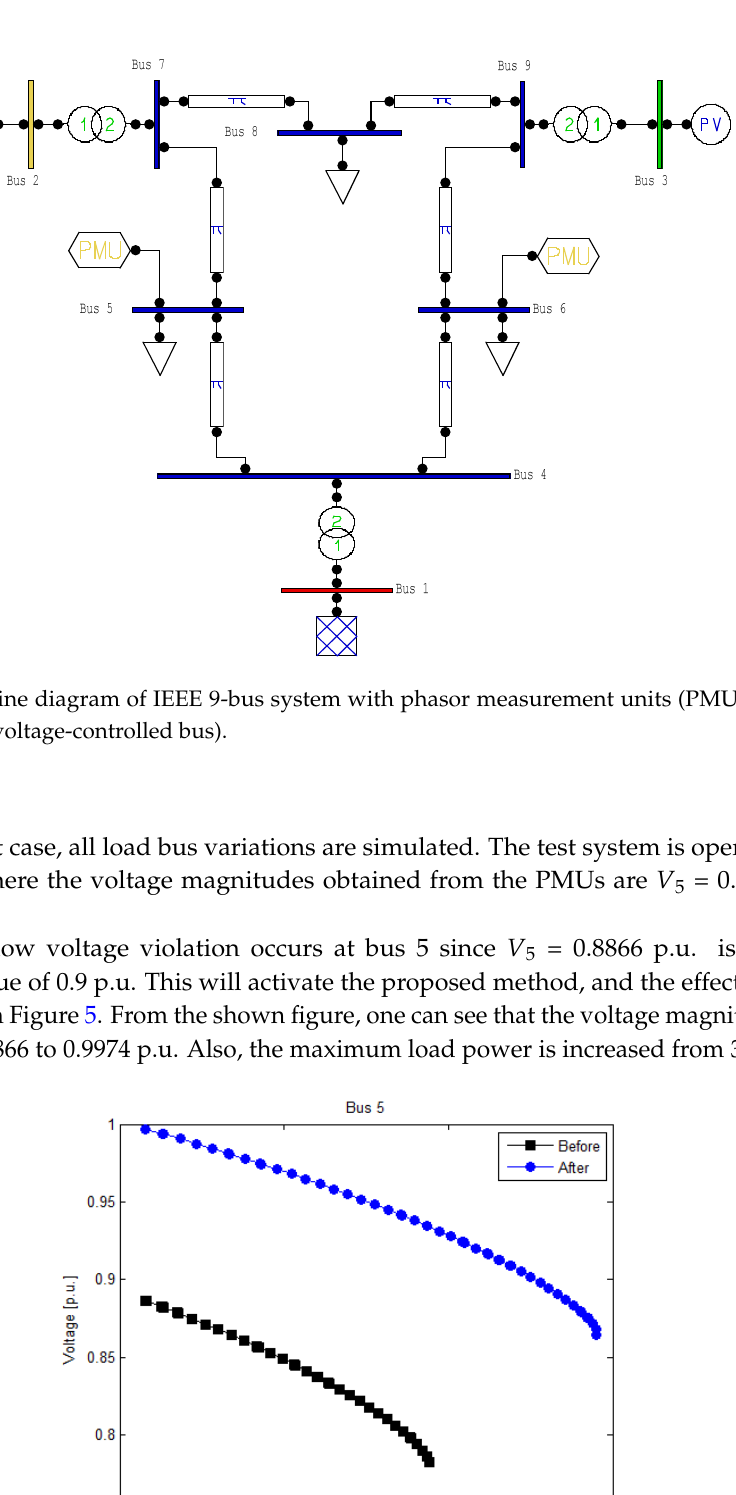
Figure 5. Simulation result of Case 1 for IEEE 9 ‐ bus.